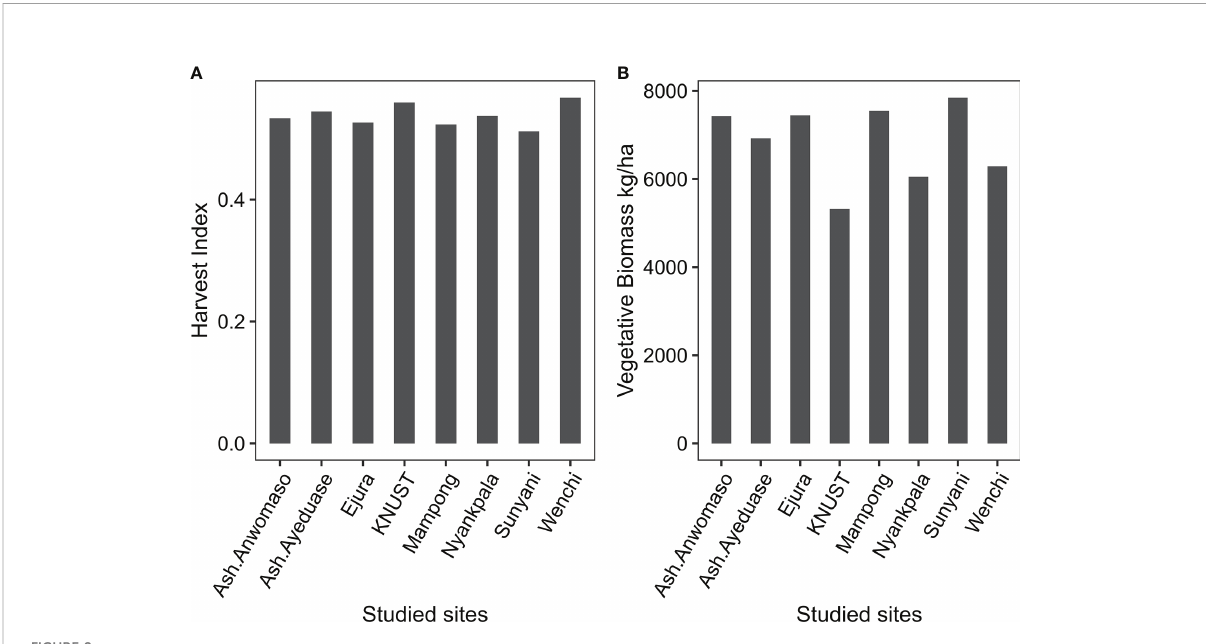
FIGURE 8 (A) Harvest index and (B) shoot biomass simulated in the study locations using